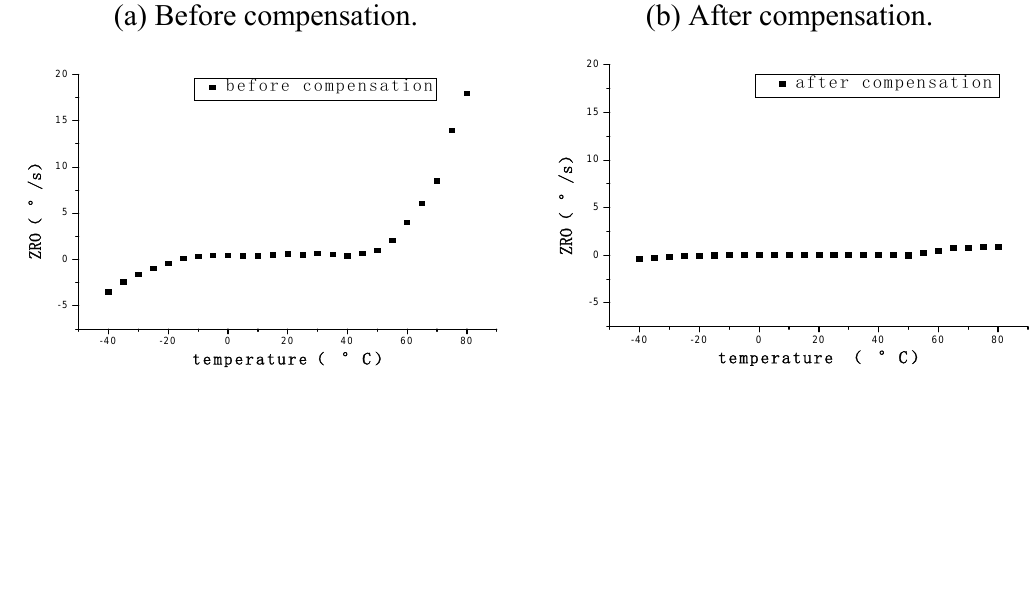
Figure 14. Efforts of temperature on ZRO before and after compensation. (a) Before compensation. (b) After